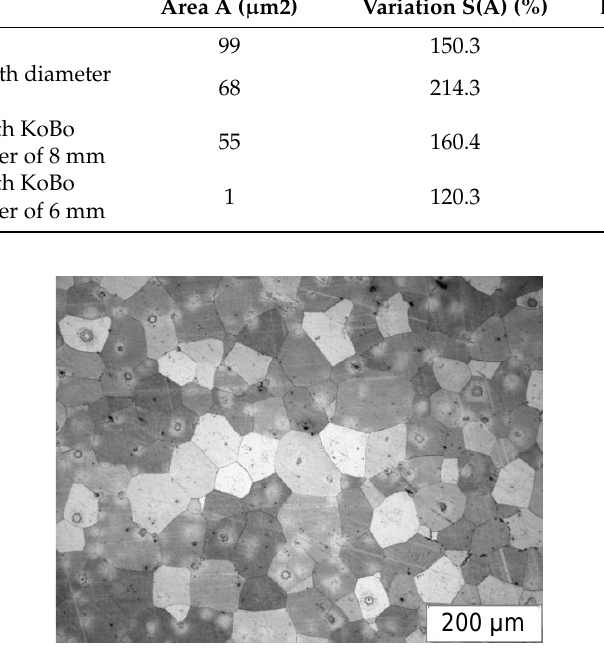
Figure 3. Microstructure of WE43 alloy after casting process and solution heat treatment. Table 2. Results of quantitative characterization of the WE43 alloy after applying the KoBo method